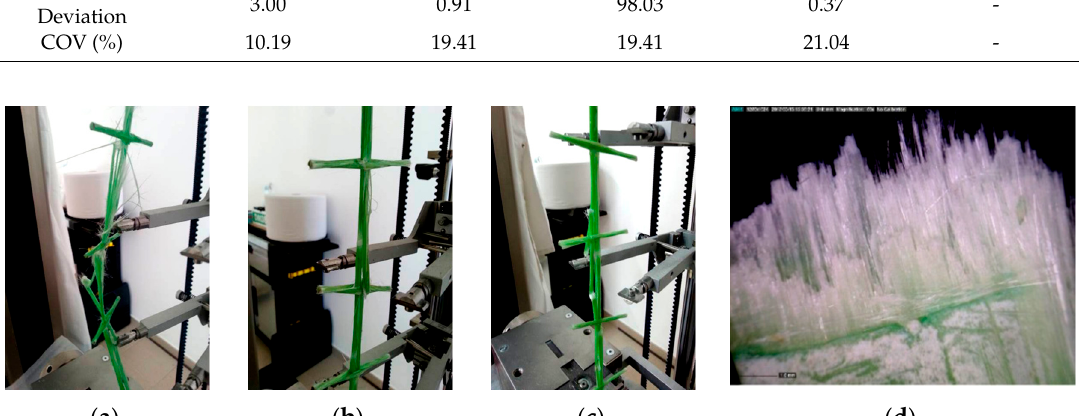
Figure 7. Typical tensile failures of GFRP specimens. ( a ) and ( b ) near the joint; ( c ) tensile failure; ( d ) detail of the specimen’s section after tensile failure.